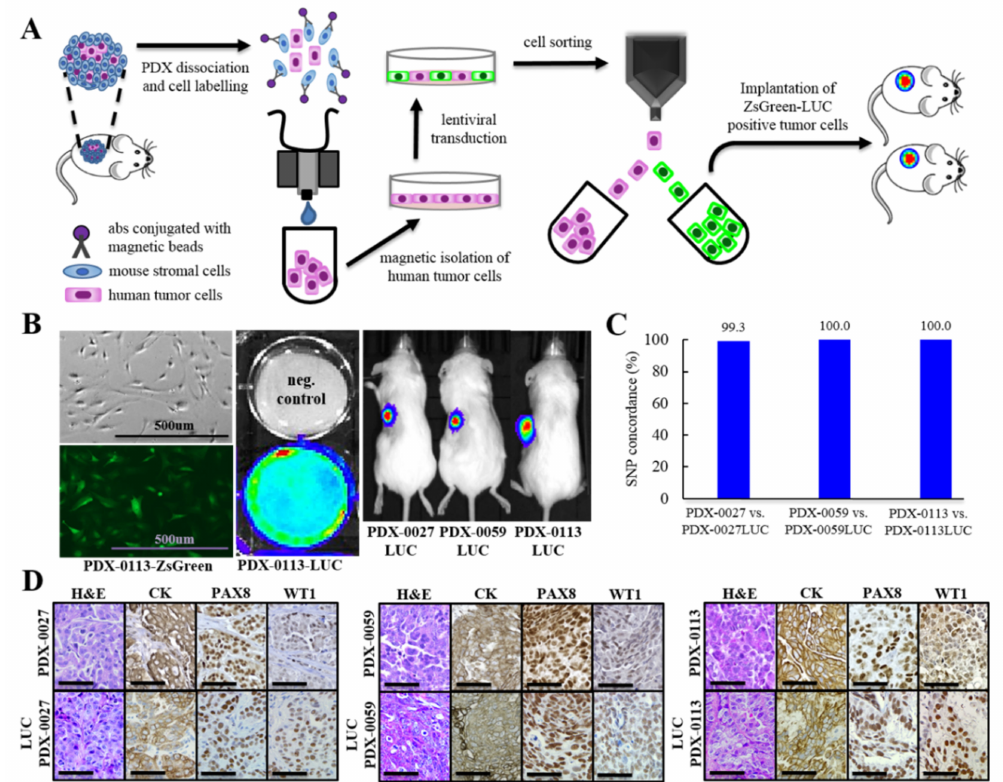
Figure 6. Luciferization of PDX models for non-invasive in vivo imaging. ( A ) Schematic representing a process of PDX luciferization. ( B ) Pictures show a successful transduction of primary tumor cells isolated from PDX with bicistronic lentiviral vector expressing ZsGreen (fluorescence microscopy, left panel), and expressing LUC (bioluminescence imaging of cells, middle panel). Right panel shows bioluminescence imaging of luciferized PDXs in vivo. ( C ) Analysis of 300 SNPs that frequently occur in human genome in parental PDX lines and their luciferized counterparts. ( D ) Tumor sections of PDX models with and without LUC expression were H&E stained and evaluated by IHC for HGSOC subtype markers. Scale bars: 50 µ